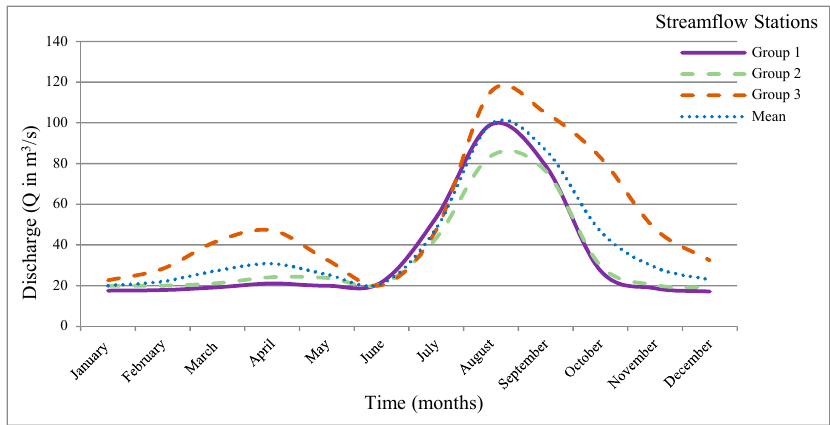
Figure 7. The mean monthly river discharge in ARB at Group 1, 2 and 3.